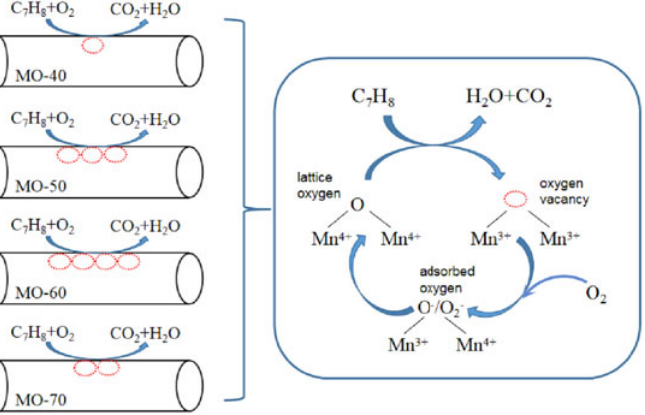
Figure 13. Mechanism of toluene oxidation on α -MnO 2 . Reprinted with permission from Ref. [99]. Copyright 2021 Elsevier.